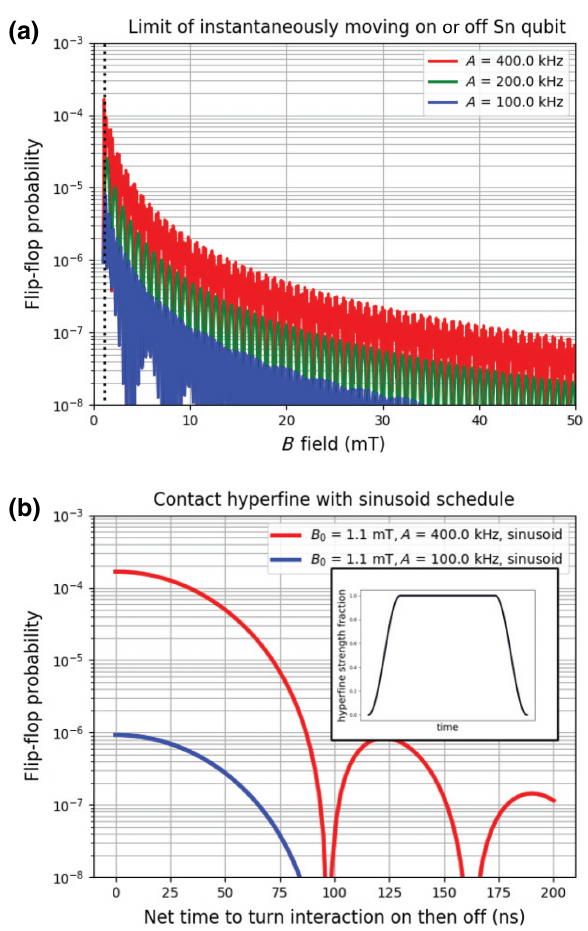
FIG. 4. (a) The diabatic flip-flop probabilities as a function of the external B field for three different HFI strengths taken in the limit of instantaneous HFI on-off switching. A vertical dotted line marks B 0 = 1.1 mT, which is used in (b). (b) The diabatic flip- flop probabilities as a function of the net on-off switching times at B 0 = 1.1 mT, using a sinusoid shape for the hyperfine transitions as depicted in the inset. The probabilities can improve by using slow and smooth transitions but this is not necessary if a modest B -field strength is